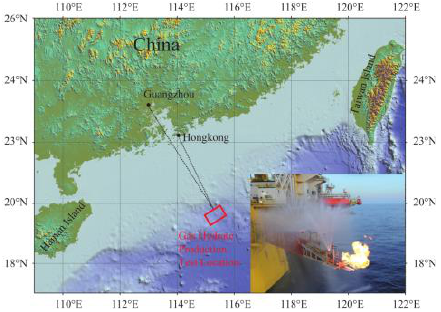
Figure 1. Location of the NGHs test extraction area in Shenhu Sea, South China Sea.